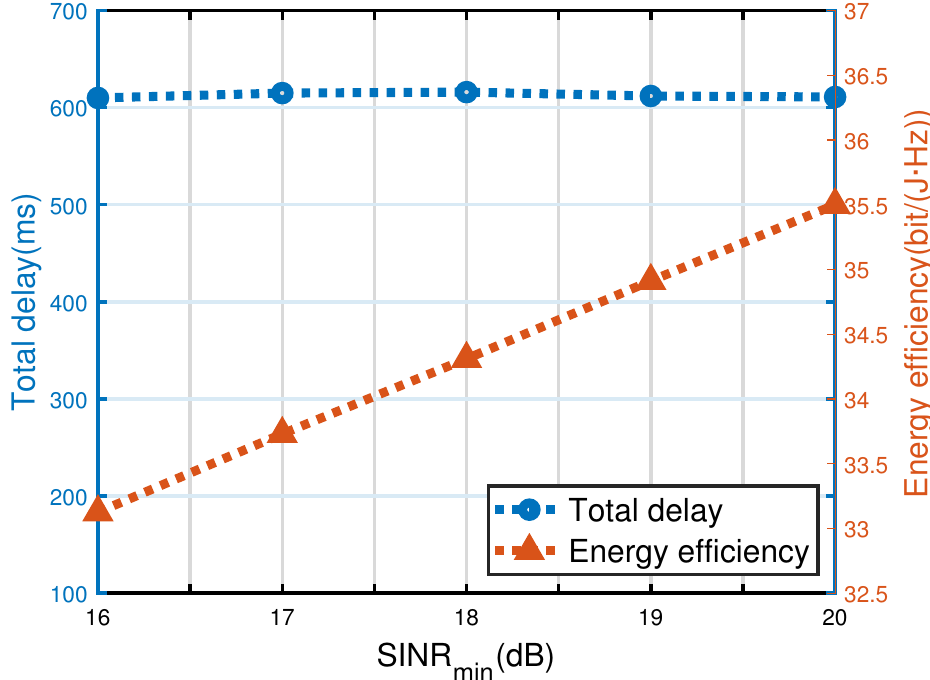
Figure 7. Total delay and energy efficiency versus SINR min .